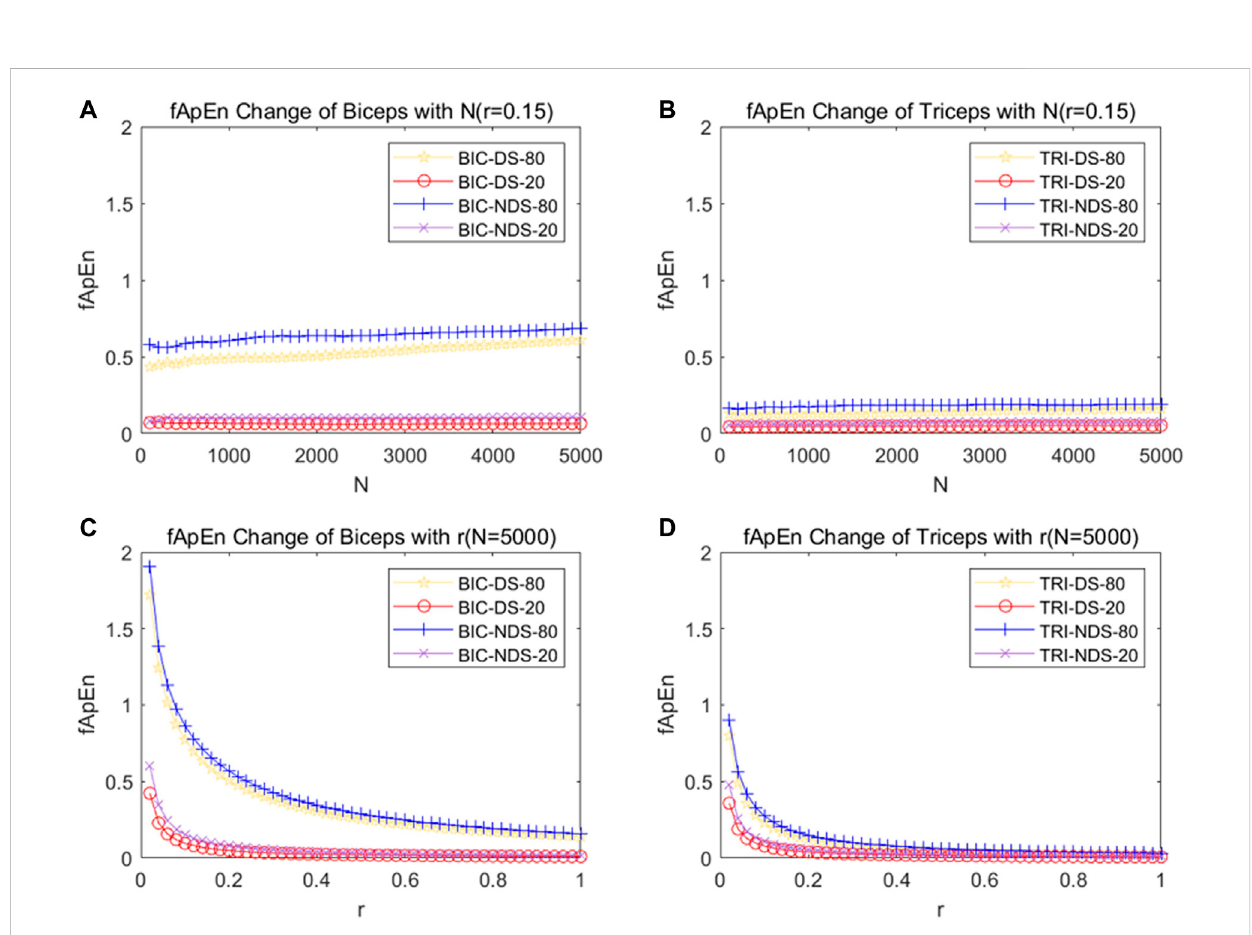
FIGURE 6 (A) ChangeoffApEn ofBICwith thechangeofwindow N. (B) ChangeoffApEnofTRIwiththechangeofwindowN. (C) ChangeoffApEn ofBICwith the change of tolerance r. (D) Change of fApEn of TRI with the change of tolerance r. EMG signals were picked out from four different conditions from a subject. Abbreviation: DS, dominant side; NDS, non-dominant